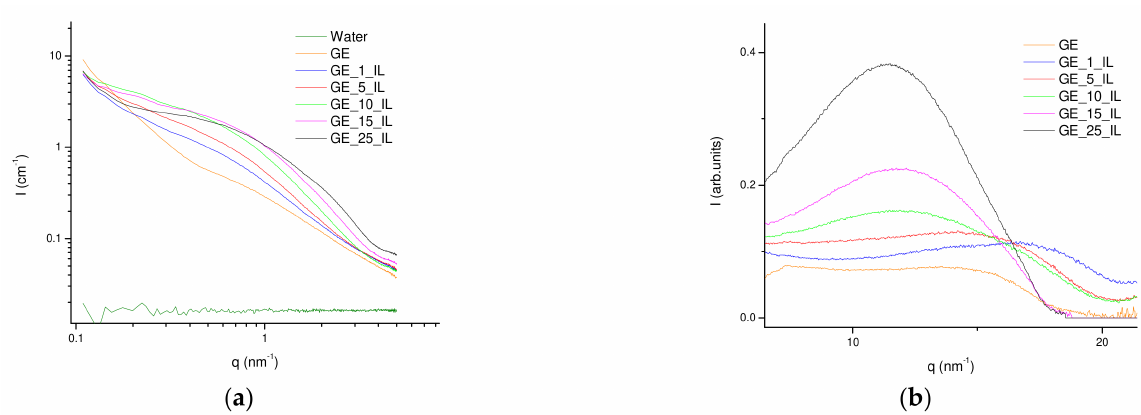
Figure 14. ( a ) SAXS and; ( b ) WAXS profiles of the Ionogels at different